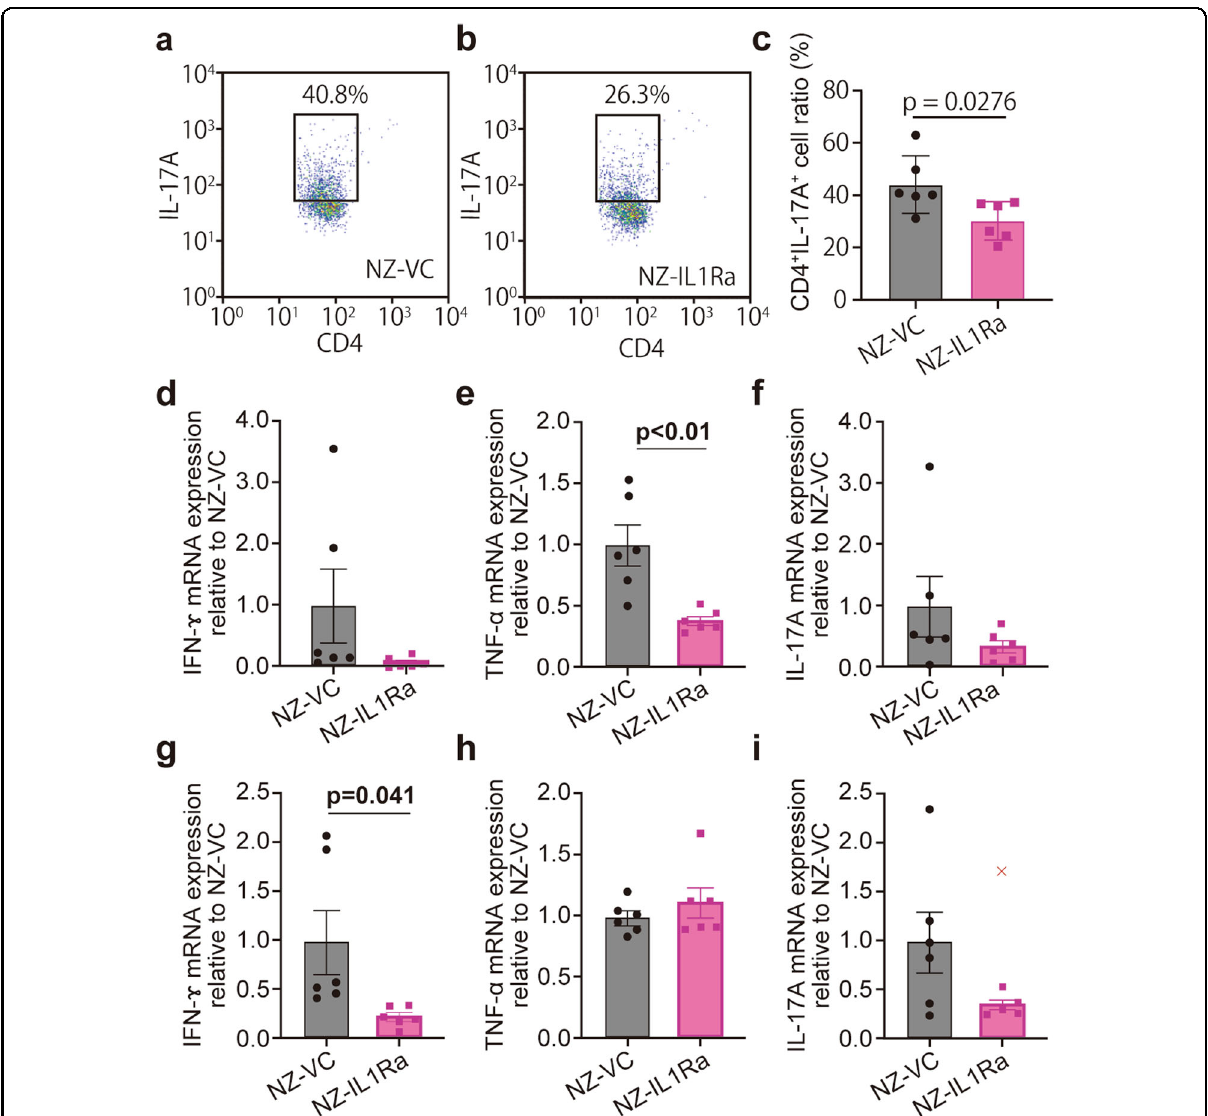
Fig. 6 Anti-in fl ammatory effect of NZ-IL1Ra on cytokine expression. a – c MLNs excised on day 11 were stained with an Alexa Fluor488 anti- mouse CD4 antibody and a PerCP/Cy5.5 anti-mouse IL-17A antibody. Representative fl ow cytometry dot plots of CD4 + IL-17A + cells in NZ-VC ( a ) and NZ-IL1Ra groups ( b ) are shown. c Graph showing the average percentage of CD4 + IL-17A + cells. Data are the mean ± SE ( n = 6), and each dot in the plot represents one mouse. d – i Graph showing relative expression levels of IFN- γ ( d , g ), TNF- α ( e , h ), and IL-17A ( f , i ) mRNA in the colon and MLNs, respectively. Values are shown relative to the NZ – VC group, and signi fi cant differences are indicated by p values. Data are the mean ± SE ( n = 6), and each dot in the plot represents one mouse ( “ x ” notations indicate